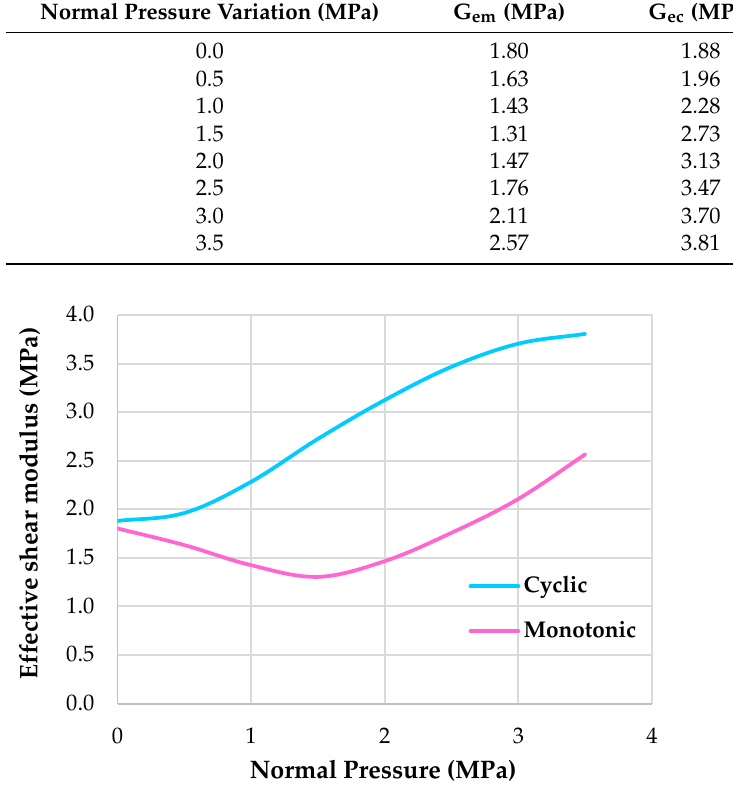
Figure 13. Summary of the calculated effective shear moduli of the proposed model at different normal pressures for both monotonic and cyclic analysis.